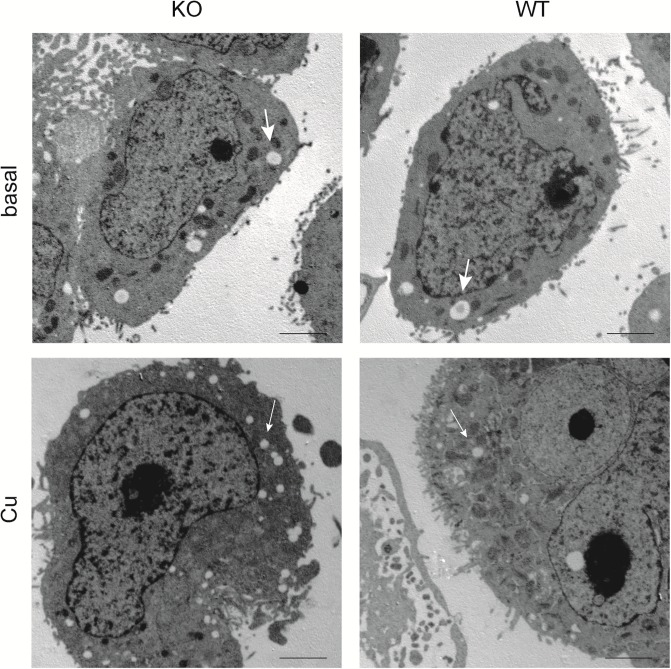
Accumulation of lipid droplets in KO cells.Electron microscopy images of KO and parental cells (WT) are shown. Large sized (bold arrows) and small sized LDs (plain arrows) are depicted. Cells were incubated in basal medium (top) and following Cu treatment (bottom). Note, accumulations of small sized LDs after Cu treatment. One representative experiment of six is shown. Scale bar, 2 μm.